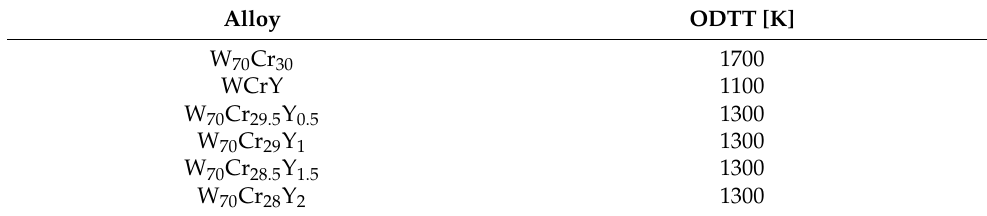
Table 2. Order–disorder transition temperatures for alloys in Cr-W-Y system.